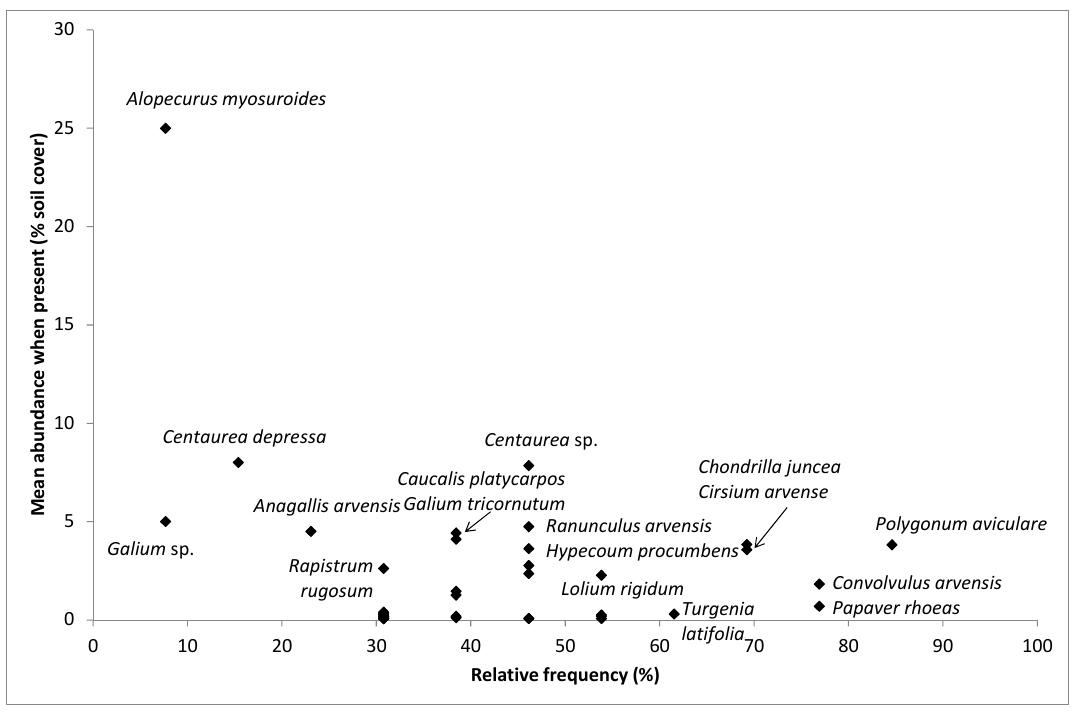
Figure 4. Species relative frequency and mean abundance when present in organic cereal fields (OC). Data of years 2013–2014 pooled together. Named species are the most abundant and most frequent ones.